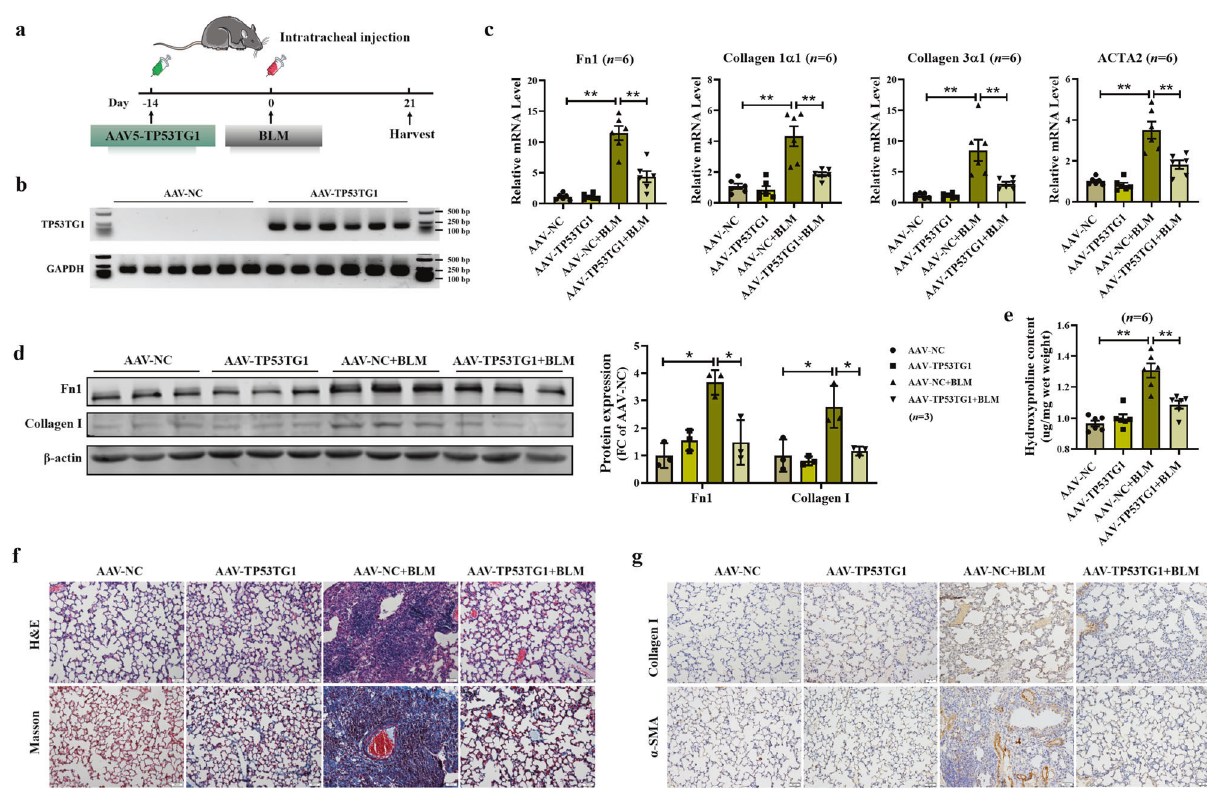
Fig. 2 BLM-induced lung fi brosis is suppressed by preventive TP53TG1. a Diagram of the animal experimental mode. Mice received intratracheal injection of AAV5-TP53TG1 14 days before BLM induction, and lung tissues were harvested 21 days later. b TP53TG1 was signi fi cantly overexpressed in lung of AAV5-TP53TG1 infected mice con fi rmed by agarose gel electrophoresis; n = 6. c The relative expression of fi brosis related genes induced by BLM was suppressed by prior injection of AAV5-TP53TG1. d The effect of TP53TG1 on the protein levels of Fn1 and Collagen I in vivo was assessed by Western blots. e Hydroxyproline content was signi fi cantly reduced in the lungs of AAV5-TP53TG1 treated mice. f H&E and Masson staining indicated that TP53TG1 inhibited BLM-induced lung morphological changes and increased fi brotic area; n = 3. g Immunohistochemical experiments detected lighter staining for Collagen I and α -SMA in the AAV5-TP53TG1-treated BLM-mice; n = 3. * P < 0.05; ** P < 0.01. BLM, bleomycin; AAV-TP53TG1, adeno-associated virus 5 containing TP53TG1; FC fold